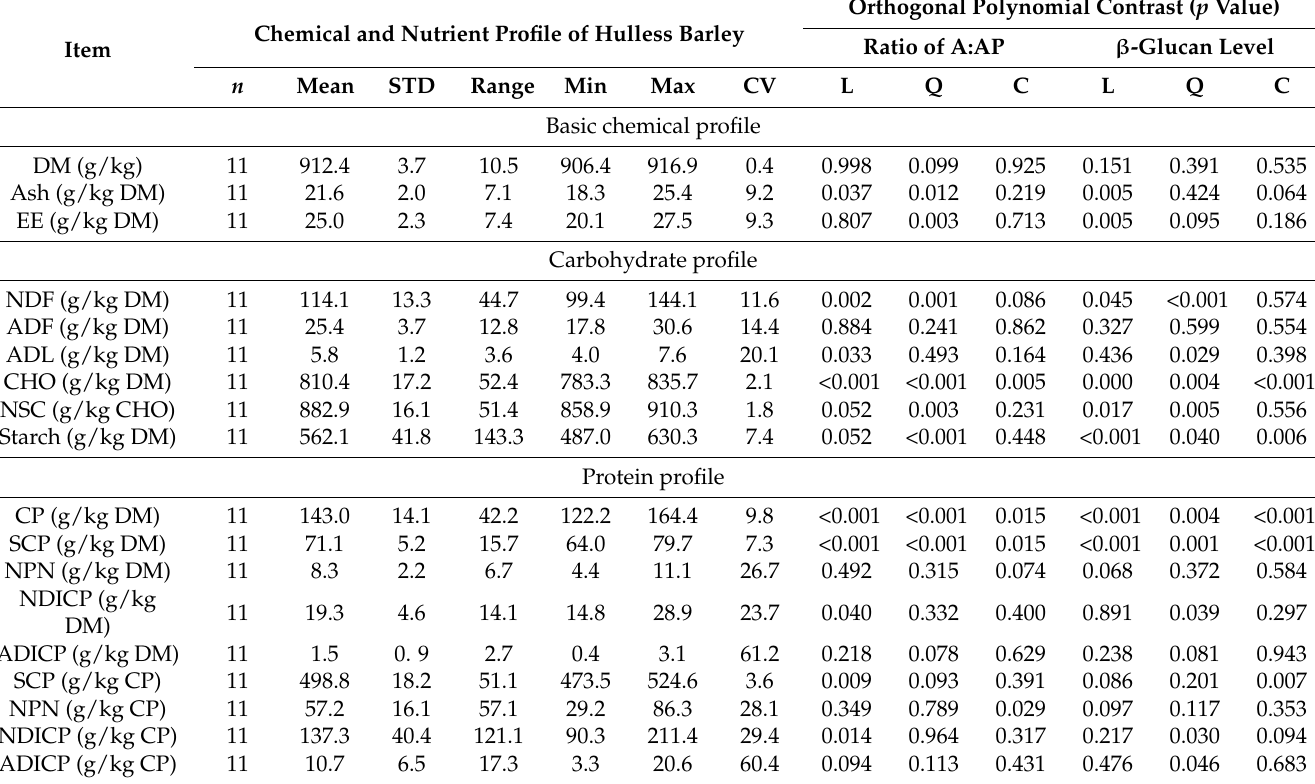
Table 1. Curve-linear response of chemical and nutrient profiles to altered carbohydrate macromolecular structure traits in Crop Development Center (CDC) hulless barley